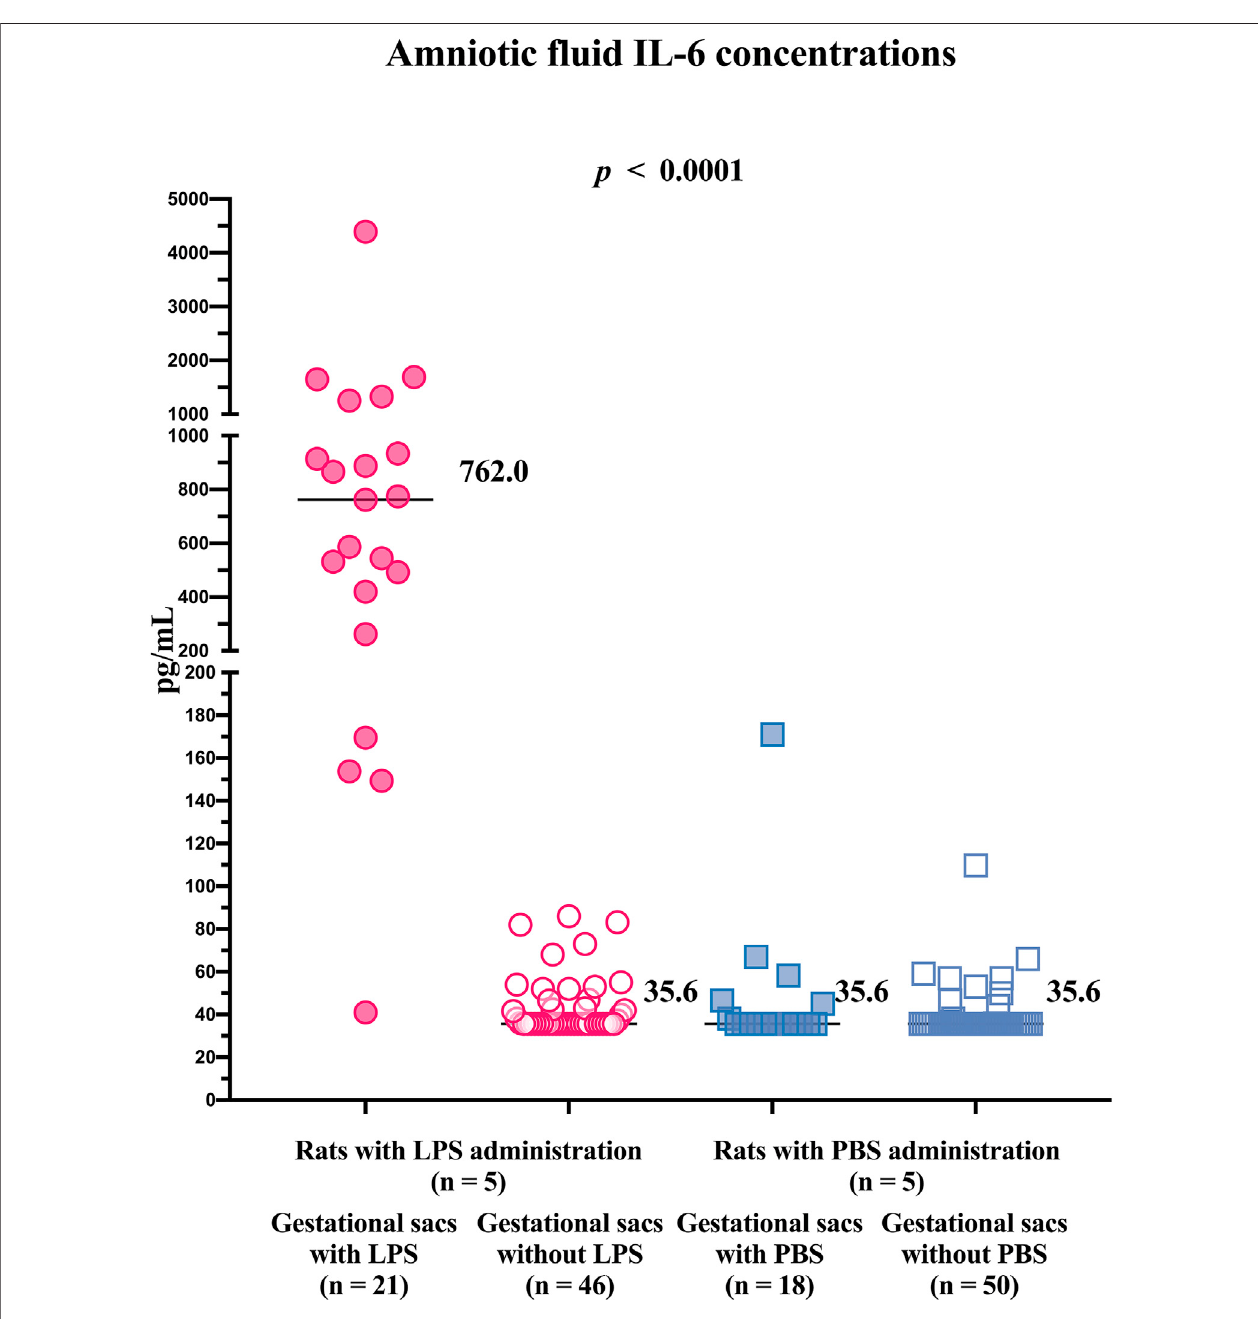
FIGURE 3 | Concentrations of IL-6 in the amniotic fl uid from individual gestational sacs of rats after an ultrasound-guided transabdominal intra-amniotic administration of either lipopolysaccharide or phosphate-buffered saline. LPS, lipopolysaccharide; PBS, phosphate-buffered saline; and IL, interleukin.